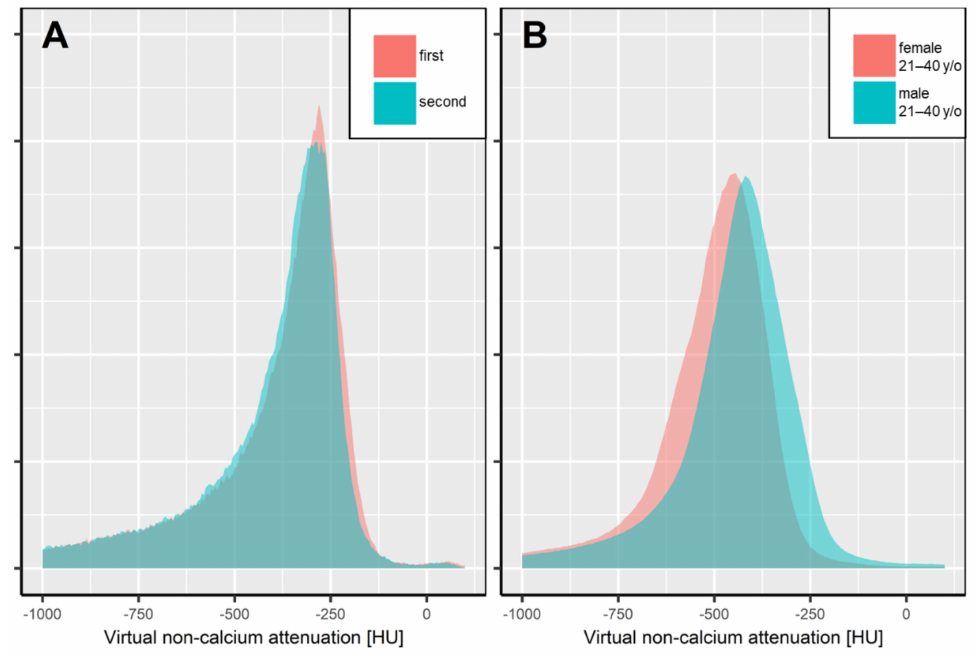
Figure 2. Intra- ( A ) and interindividual ( B ) overlap of automated, volumetric bone marrow attenua- tion